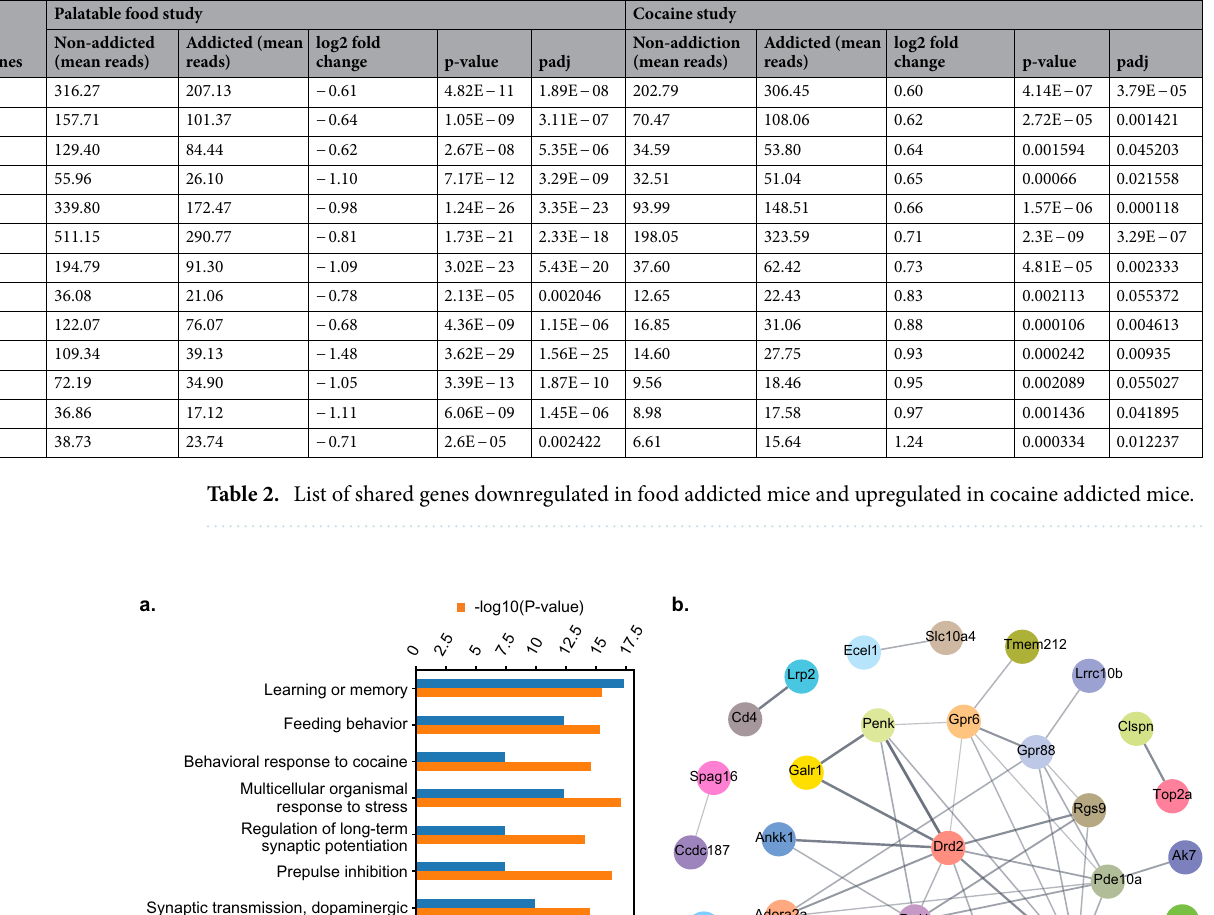
Table 1. List of common upregulated genes in palatable food and cocaine addicted mice.